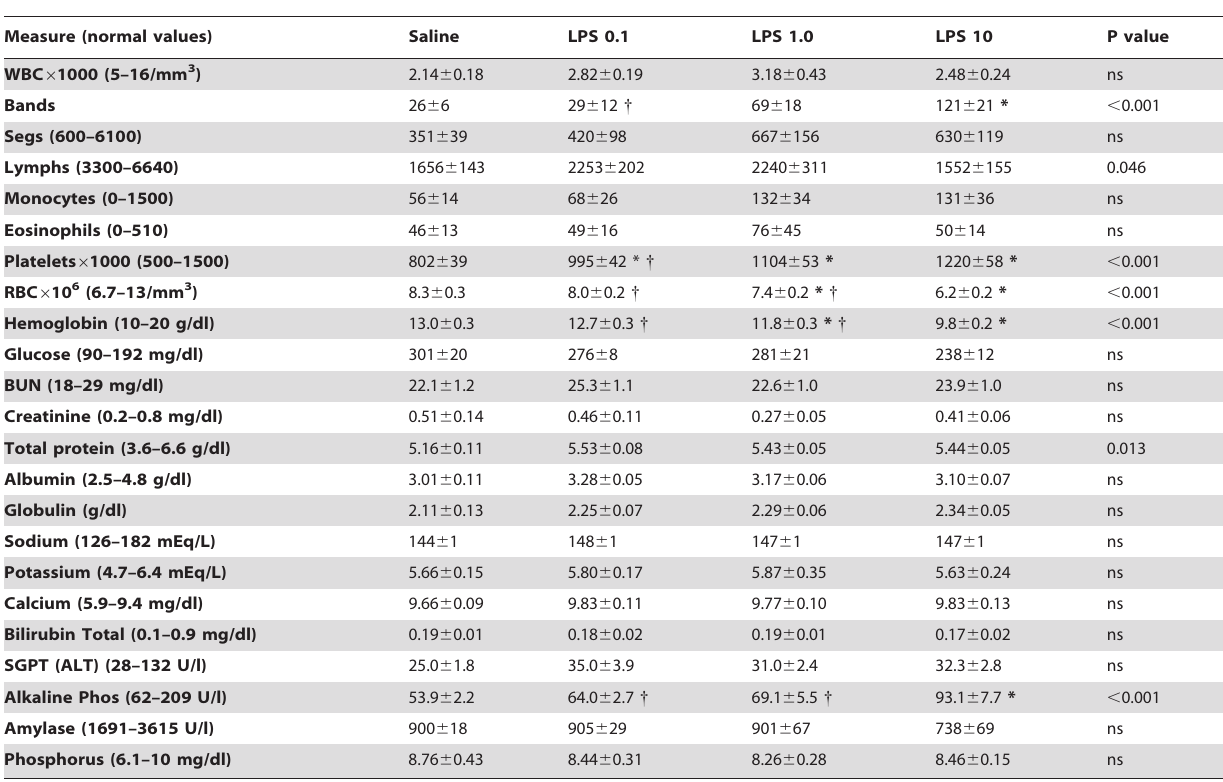
Table 1. Complete blood counts and